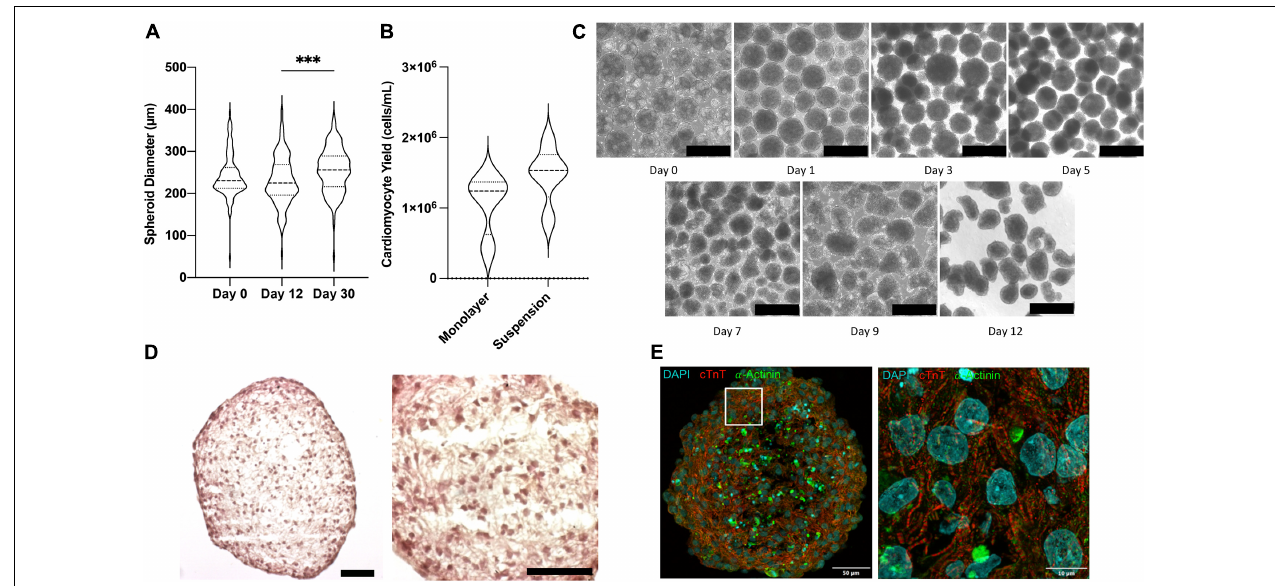
FIGURE 2 | Morphological characterization of CM spheroids. (A) Violin plot of spheroid size determined from bright field images on day 0, 12, and 30 of differentiation ( n > 150). (B) Violin plot of cardiomyocyte yield on day 12 in monolayer and suspension culture systems determined as cells per volume of media ( n = 4). (C) Bright field photos of differentiating spheroids over time. Scale bar = 500 µ m. (D) H&E stained parafin sections of day 12 beating cardiomyocyte spheroids. Scale bar = 50 µ m. (E) Flourescently stained cryosection showing cardiomyocytes muscle fiber striations. ∗∗∗ p <